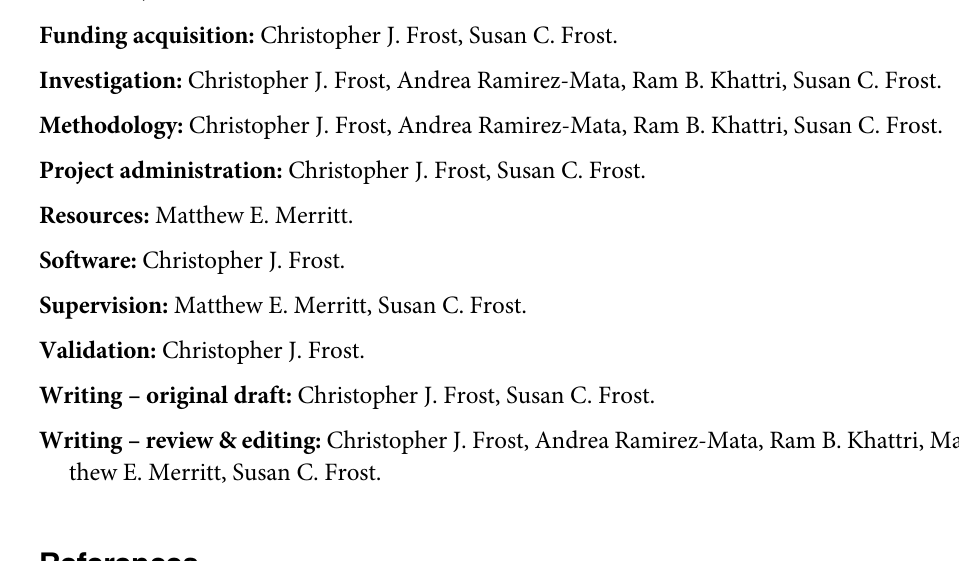
S1 Raw images. PDF version of raw original western blot images for GAPDH, ERK, and pERK expression that are presented in Fig 8A. Individual films for each of the proteins assessed. S1 Table. Data sets for all Figs 1–8 and S1 Fig. File contains the supplemental tables described in the manuscript. S2 Table. GO categories from S2 Fig. File contains supplemental tablular outputs for the GO category